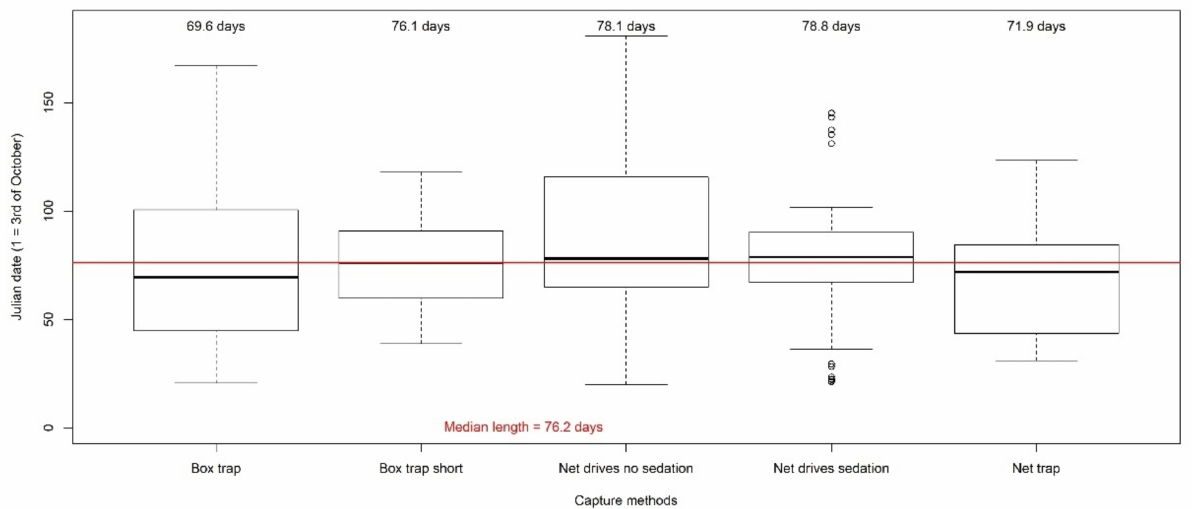
Figure A2. Duration of the sampling of roe deer from capture date to the 15 April for the five capture